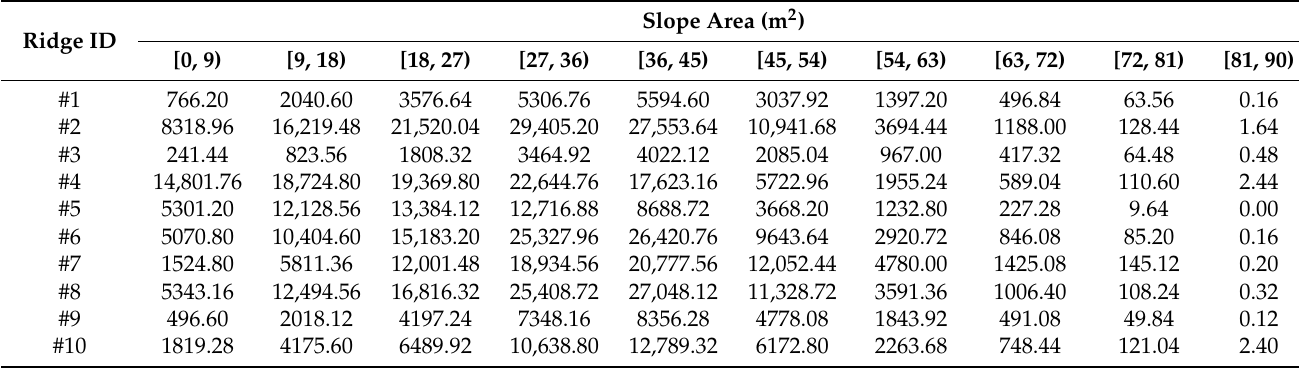
Figure 14. ( a ) Results of the percentage accumulation of the inside and outside of the slope of the pit rim structure, and ( b ) results of the percentage area of independent ridges’ slope. Table 7. Statistical results of the slope areas of independent